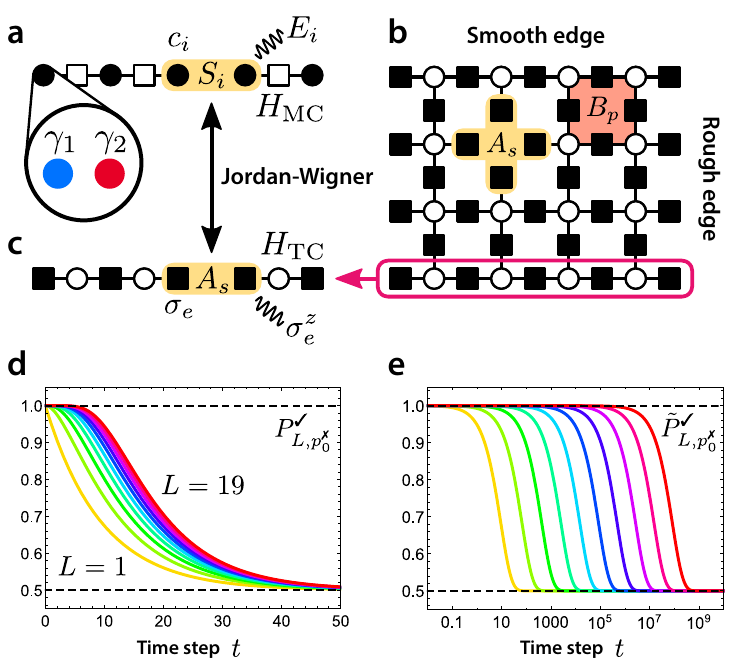
Figure 1: 1D quantum memories and global majority voting. a The Majorana chain with fermions c on sites, composed of Majorana fermions γ , parity symmetric errors E and syn- i j i drome measurements S . b The toric code on a planar square lattice with rough and smooth i edges. Stabilizers A ( B ) act on spins on edges adjacent to sites s (faces p ). c The degenerate s p L × 1 toric code is the Jordan-Wigner transform of the Majorana chain. Thus it features the (cid:51) same error syndromes and correction schemes, namely majority voting. d The probability P L , p (cid:55) 0 of correctly decoding an ensemble of L bits by global majority voting under continuous noise (cid:55) = 0.05 as a function of time t for different system sizes L = 1,...,19 without any stabilizing p 0 (cid:51) correction performed. e The same (˜ P ) for a stabilized system with global majority voting L , p (cid:55) 0 and active correction after each time step. Mind the logarithmic t